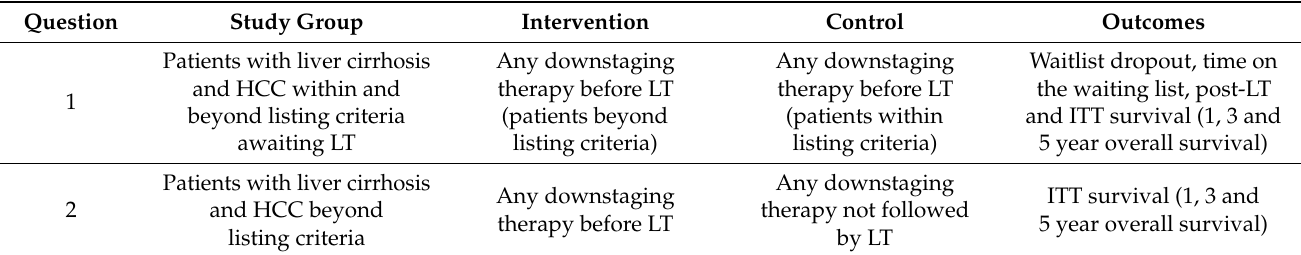
Table 1. Population, intervention, comparison and outcomes of the proposed